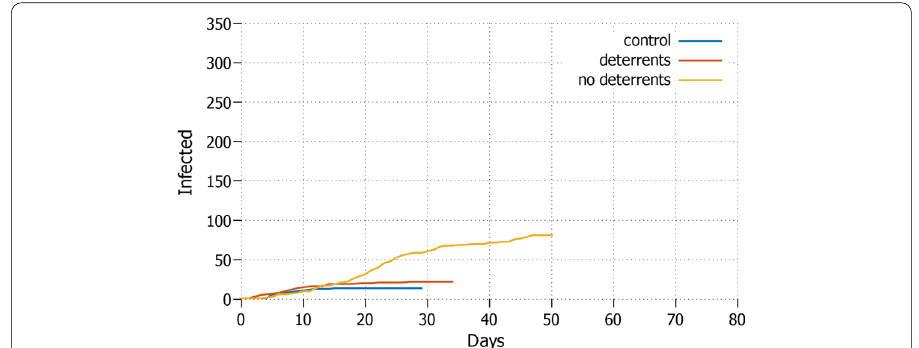
Fig. 3 All Total daily cases with all agents in lockdown and protective measures applied